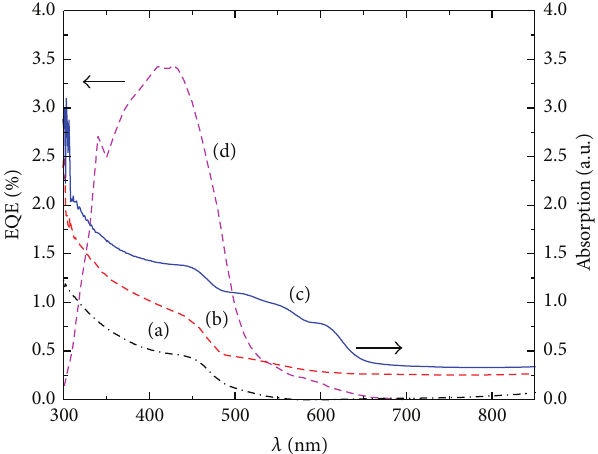
Figure 7: Optical absorbance spectra of (a) ITO/CdS-f, (b) ITO/ CdS-f/CdS-n(TU), and (c) ITO/CdS-f/CdS-n(TU):P3HT, and the external quantum efficiency of (d) ITO/CdS-f/CdS-n(TU):P3HT/ CP/Au solar cell (cell number 10 in Table